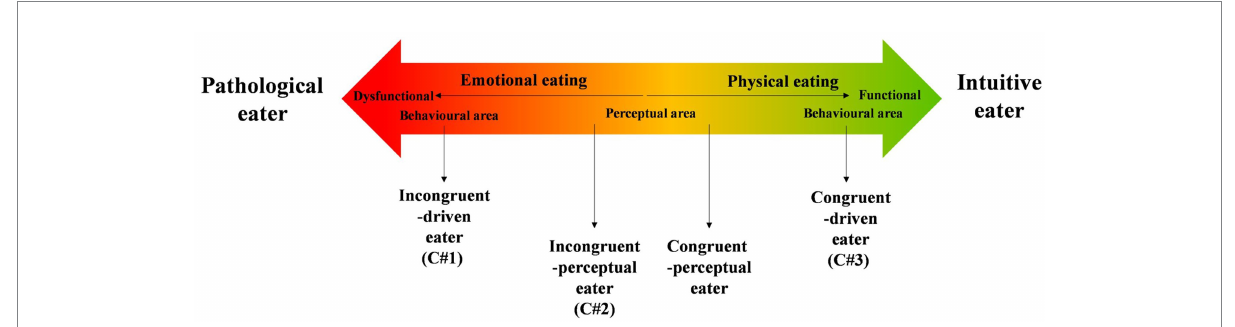
FIGURE 1 Proposed eaters continuum by perceptual-occupational-eating